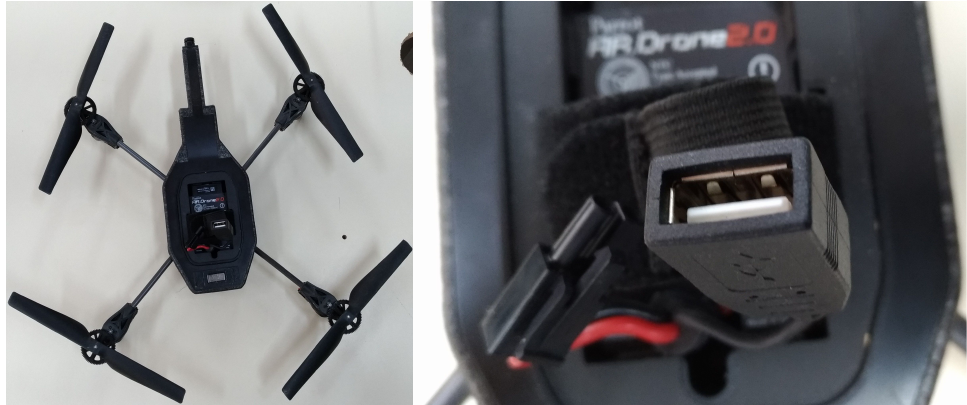
Figure 7. The Parrot AR.Drone 2.0 without its hull, highlighting its USB